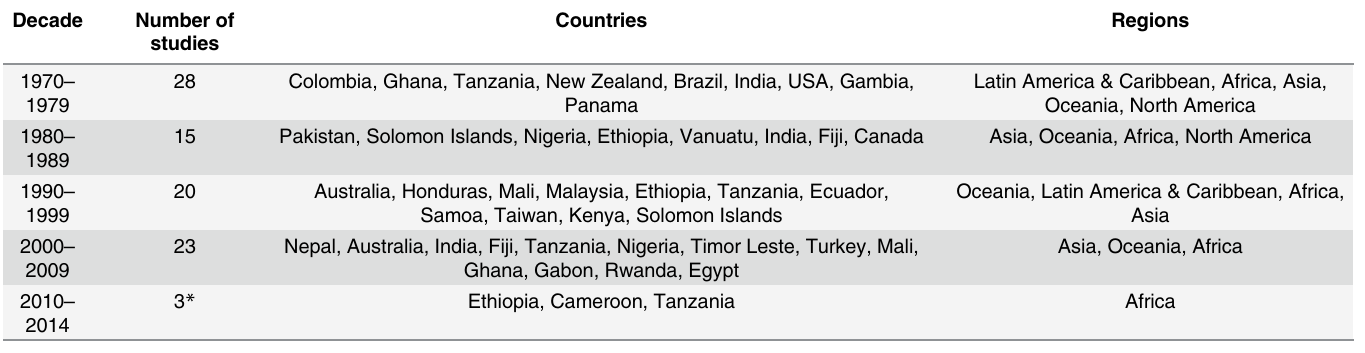
Table 1. Number of studies of impetigo prevalence by decade, country and region.